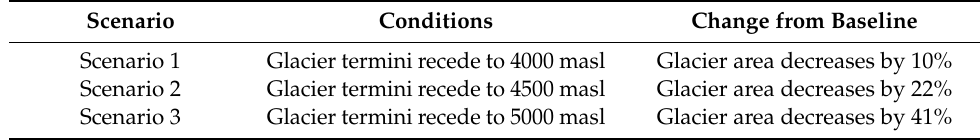
Table 4. Glacier recession scenarios.